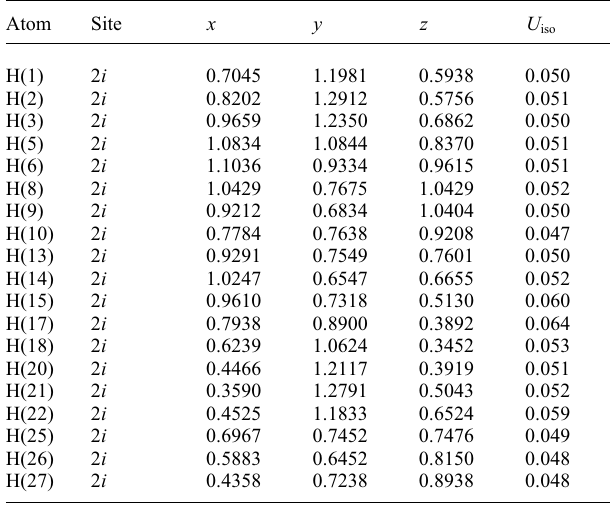
Table 2. Atomic coordinates and displacement parameters (in Å 2 )